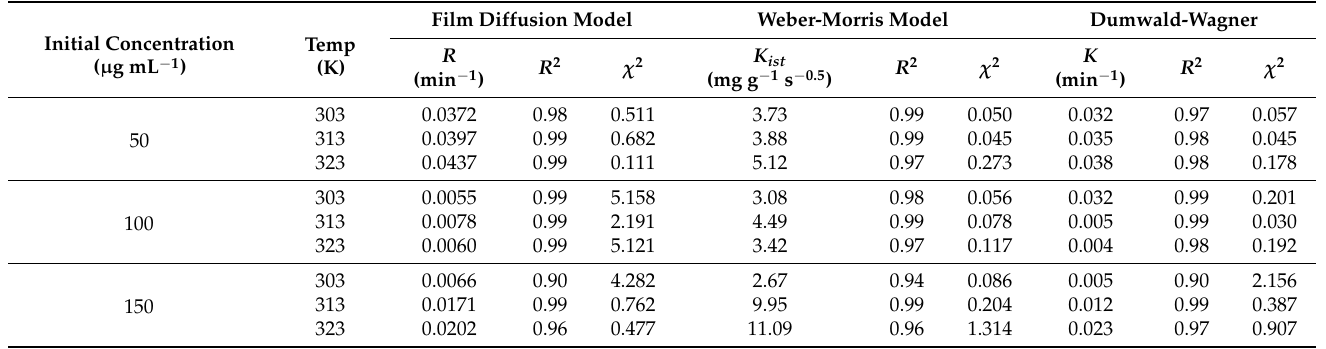
Figure 7. Energy information fitting to format the film dissemination starting with BG focus: ( a ) 50 µ g/mL and ( b ) 100 µ g/mL and ( c ) 150 µ g/mL. Table 5. Determined boundaries for the dissemination